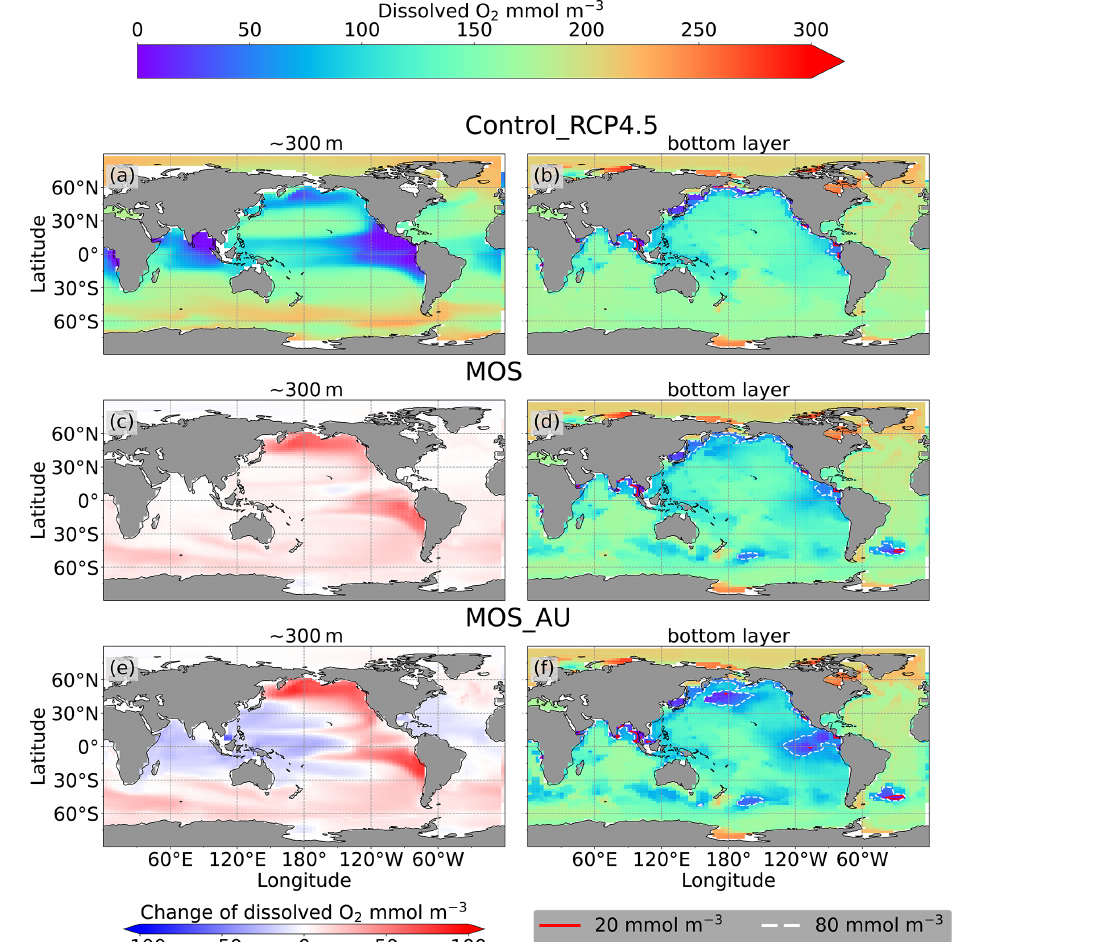
Figure 10. Dissolved O 2 concentration distribution in year 2100 at 300m depth (a, c, e) and at the seafloor (b, d, f) ; lines delineate boundaries of OMZs at any location within the water column with less than 80mmolm − 3 oxygen (dashed white) and less than 20mmolm − 3 oxygen (solid red). At 300m depth, elevated dissolved-oxygen levels in MOS simulations are caused by the decline in POC export (c) ; exceptions are the reduced oxygen concentrations in regions outside the MOS_AU deployment (e) . On the seafloor, remineralization of sunken biomass creates several new low-oxygen areas (d, f)